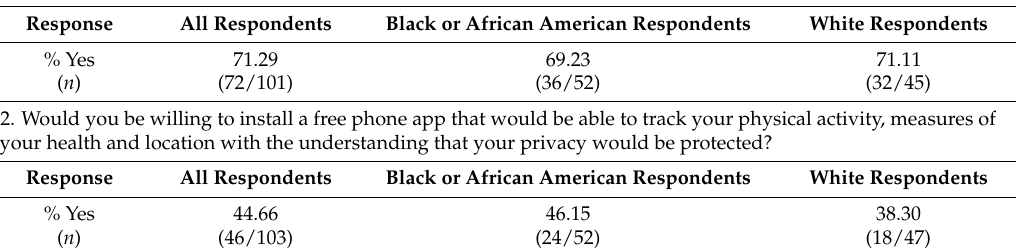
Table 2. Survey questions assessing willingness to participate in the Precision Medicine Initiative Cohort Program. A total of 103 consented patients who donated a biospecimen completed the survey.